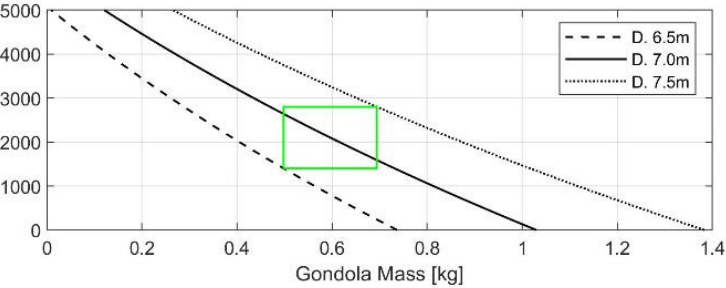
Figure 6. Dependency between gondola mass and achievable density altitude for different hull diameters. A 7 m hull is chosen as baseline in this study.